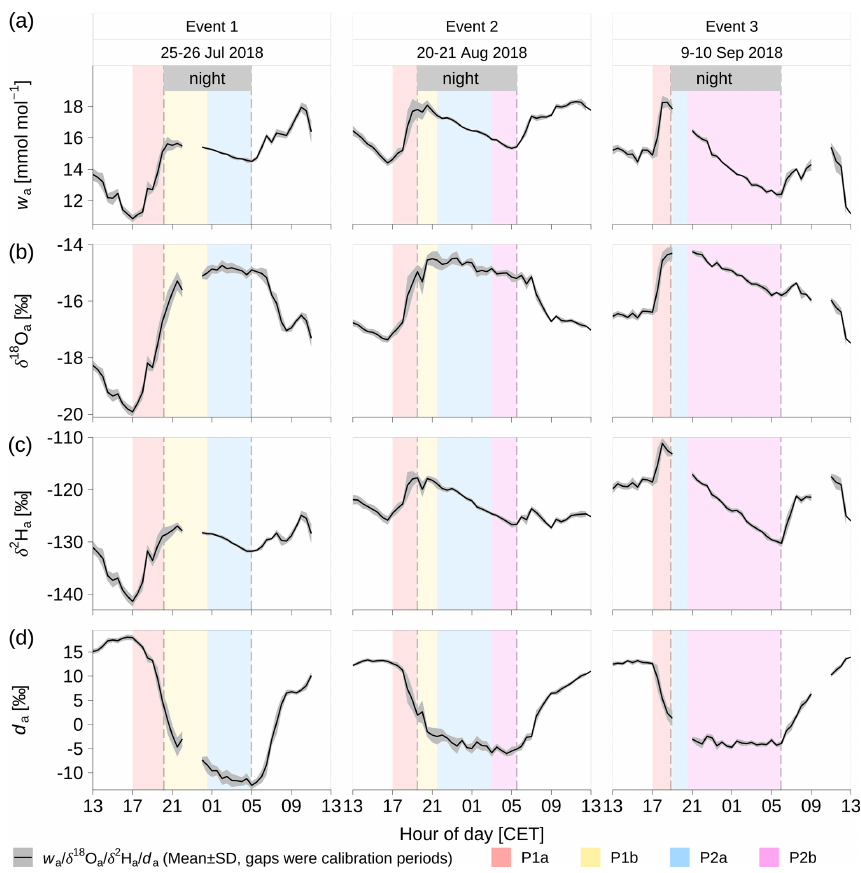
Figure 6. The 30min averages and standard deviations (mean ± SD) of the volumetric mixing ratio and isotopic composition for ambient water vapor ( w a ,δ 18 O a , δ 2 H a , and d a ). Data gaps indicate times when the automatic calibration procedure of the spectrometer was active. Vertical dashed lines show local sunset and sunrise times. The shaded areas indicated different periods of environmental conditions as described in Sect. 4.1. The P1a period was from around 17:00CET until sunset with the weakening of turbulence and the increase of specific humidity; the P1b period was from sunset until the first sign of condensation with short-term fluctuations of specific humidity; the P2a period was the dew formation period in the conditions of relative humidity < 100%; the P2b period was the combined dew and radiation fog period in the conditions of relative humidity =